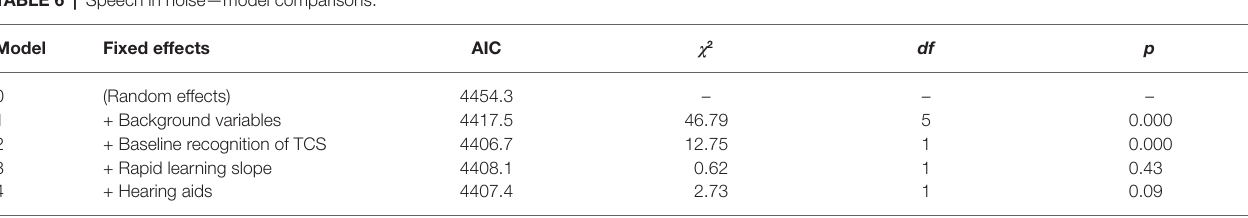
TABLE 6 | Speech in noise—model comparisons.